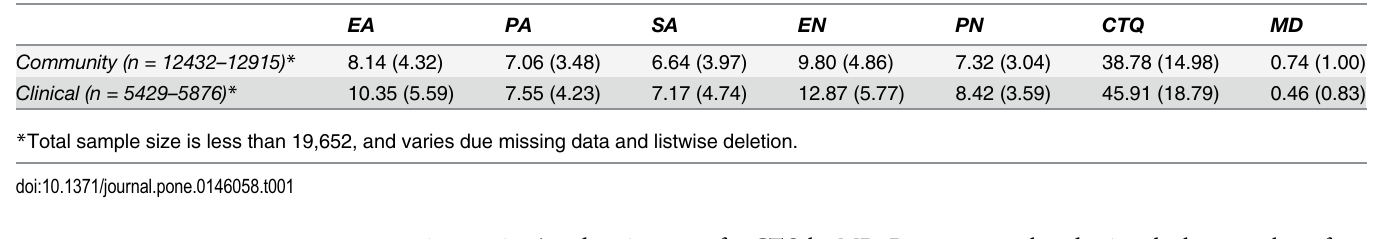
Table 1. CTQ and subscale means for clinical and community samples.